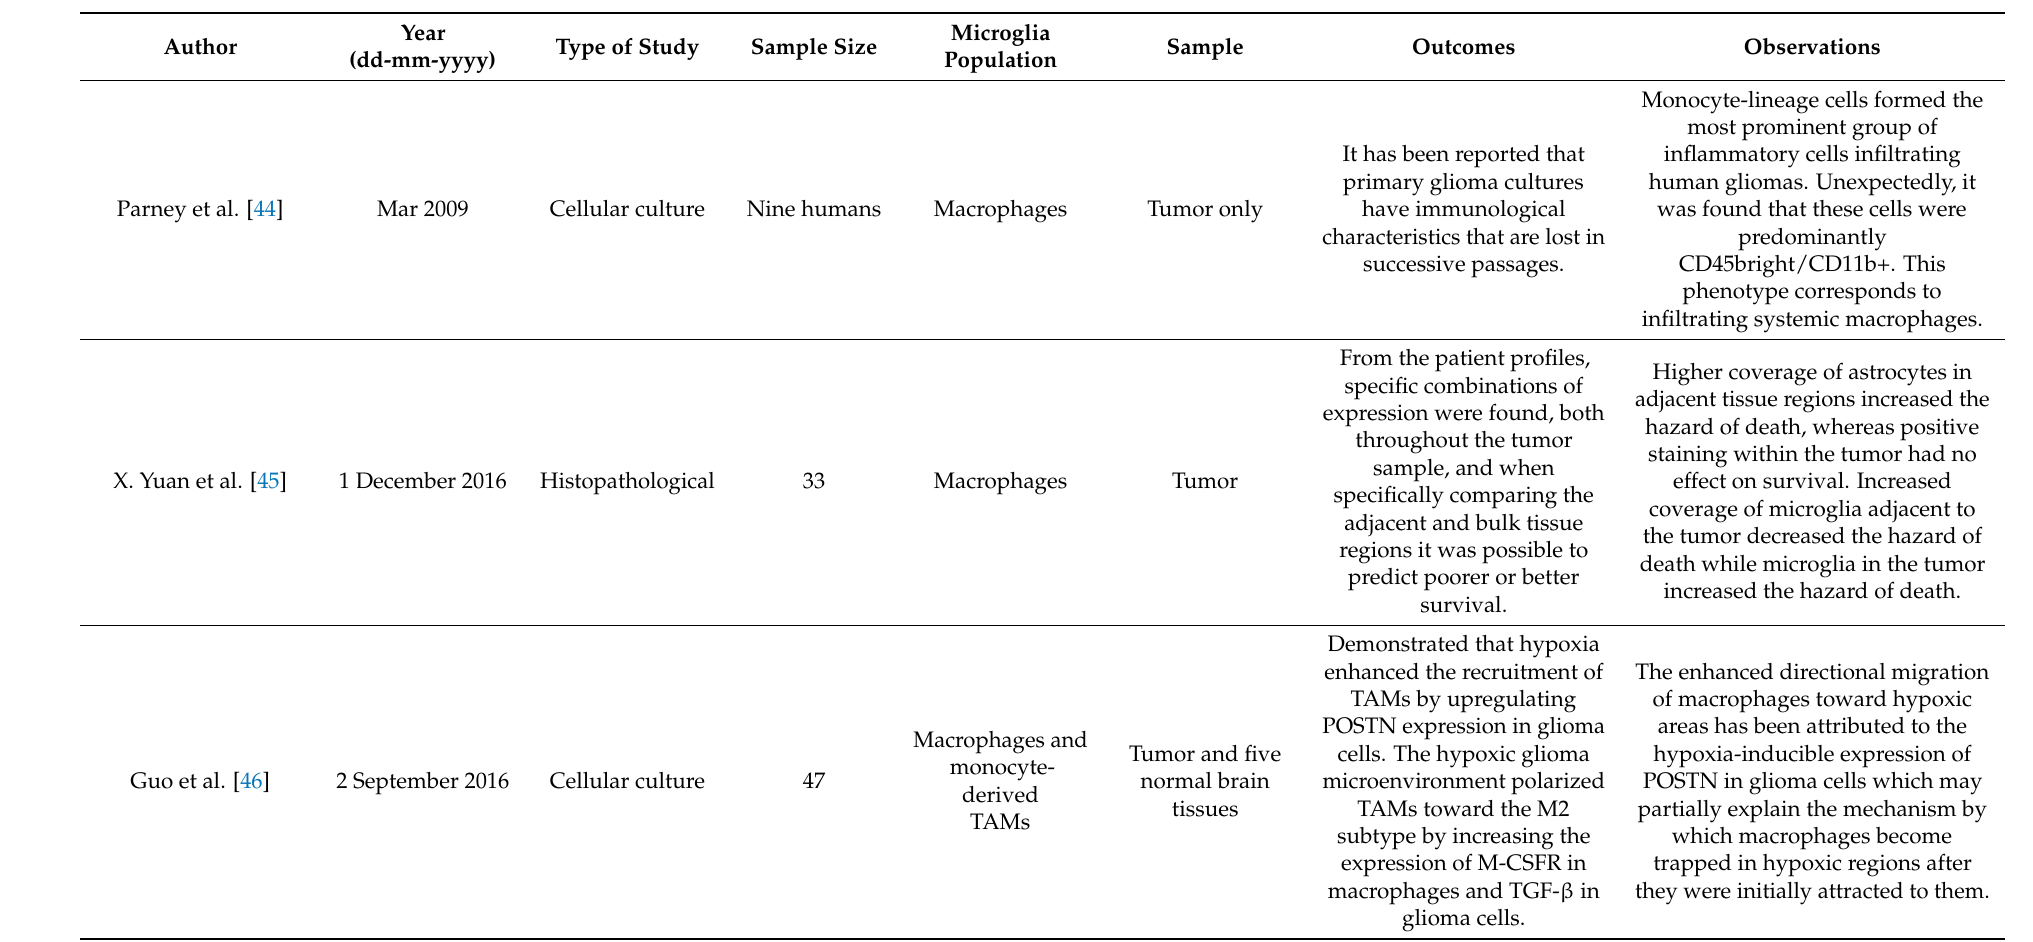
Table 3. Microglia migratory behavior and its activation